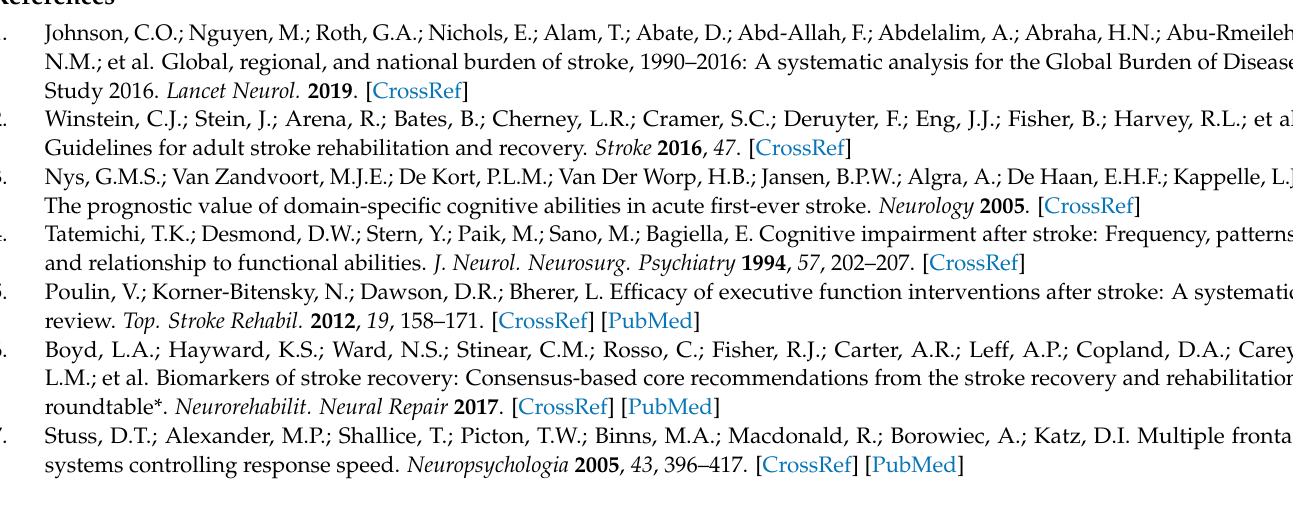
(WM) task, Figure S3: Interference Control and Inhibition (ICI) task, Figure S4: Task-Switching (TS), and Figure S5: Monitoring task (M); Table